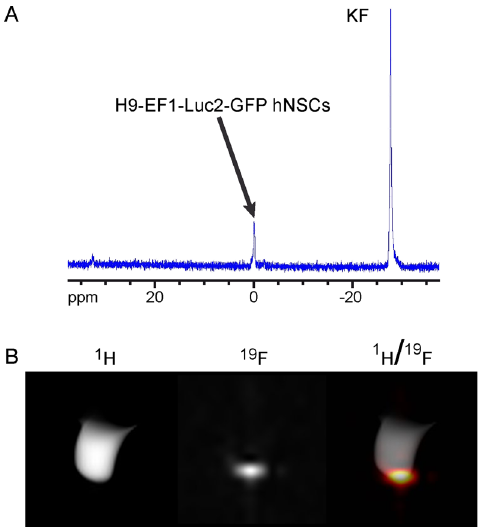
Fig 3. In vitro detectability of 19 F labeled hNSCs by means of 19 F MRI and 19 F MRS. (A) 19 F MRS of labeled hNSCs and a KF solution as internal standard to quantify the amount of 19 F atoms per cell (B) high resolution 1 H MR image (left), acquired during the same session of the labeled cells 19 F MR image (center). 1 H and 19 F images are then merged to obtain a correct spatial localization